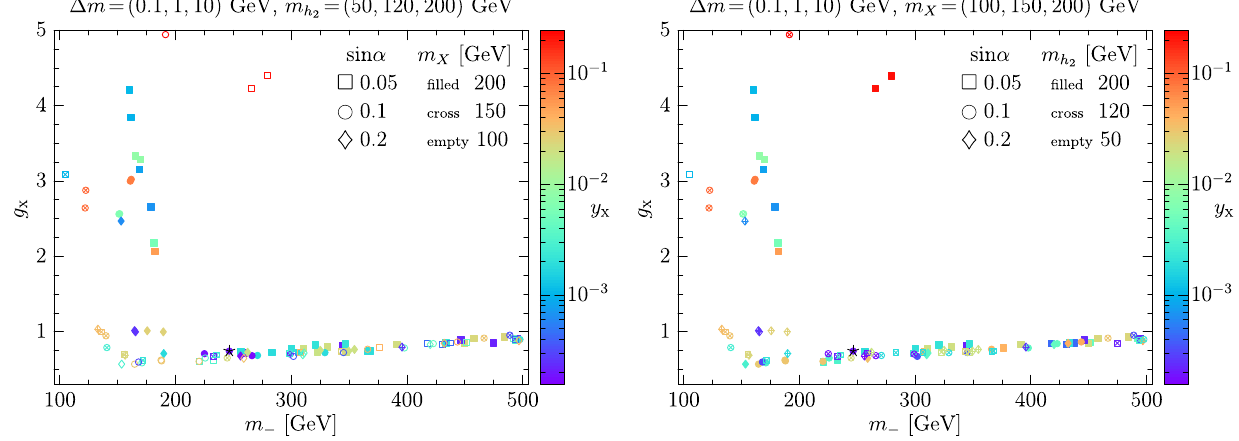
Fig. 10 These plots show results of scan over the parameter space of a satisfy the correct relic density observed by PLANCK at 5 σ and the recent direct detection experimental bound from LUX2016 at 2 σ . The 3CDM case, where X μ and ψ ± are stable. In this scan we fix three dif- point denoted by the black star (cid:19) in the these plots at m − = 246 . 4 GeV ferent values of m X , m h and Δ m and vary m − and g x as shown in the 2 plots. The left and right plots represent the same data set however points correspondstothesameparametersasthoseadoptedinthemiddlepanel markers are changed from m X (left) to m h 2 (right), whereas the color of Fig. represent the values of dark Yukawa coupling y x . All the points shown